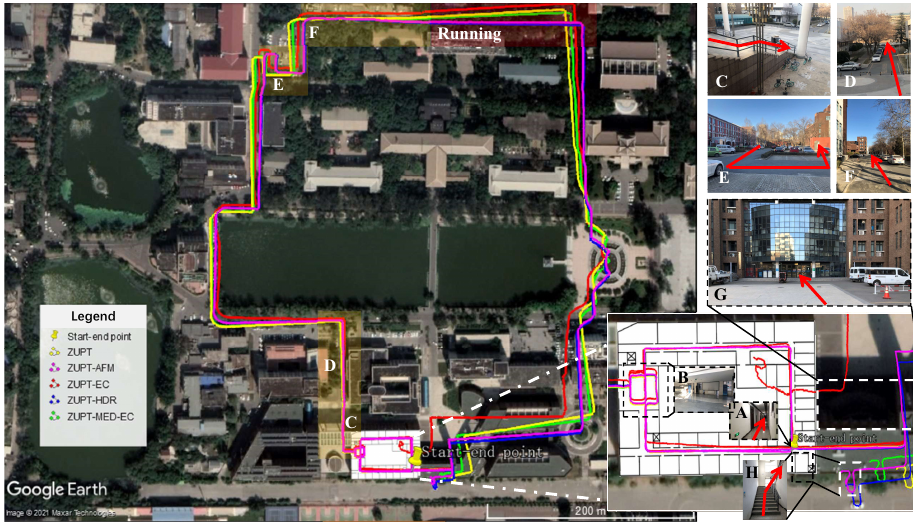
Figure 14. Estimated trajectories of the different frameworks on the indoor–outdoor 1.9 km sub-dataset. Subfigures A – H show different environments in this experiment. The red arrows in all subfigures refer to moving directions. The tester started from an indoor point (see subfigure A ) and walked toward the outdoor space through corridors, a hall (see subfigure B ), and stairs (see subfigure C ). Finally, after walking and running, the tester went back to the start point by stairs (see subfigure H